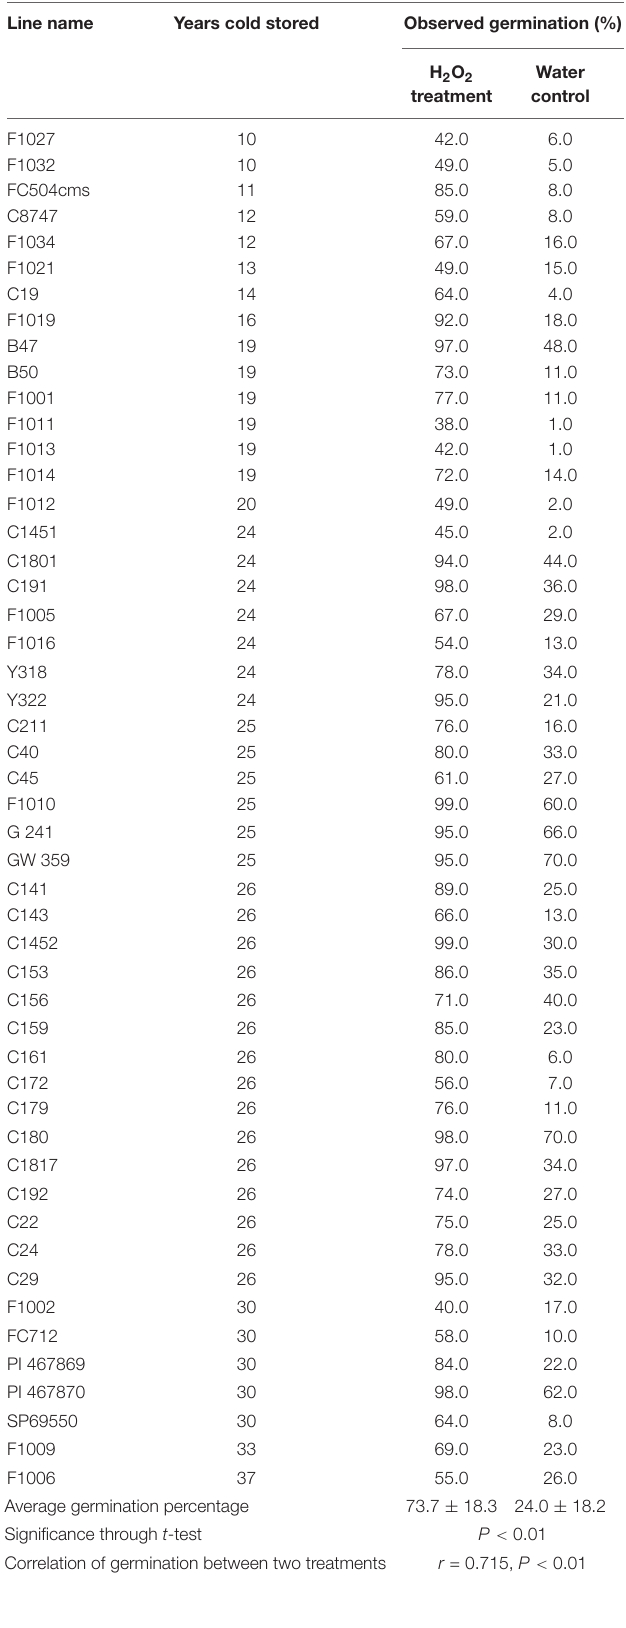
TABLE 3 | Germination percentage of seeds of 50 sugarbeet lines that were cold stored for 10–37 years after incubation in 1% H 2 O 2 or water for 8